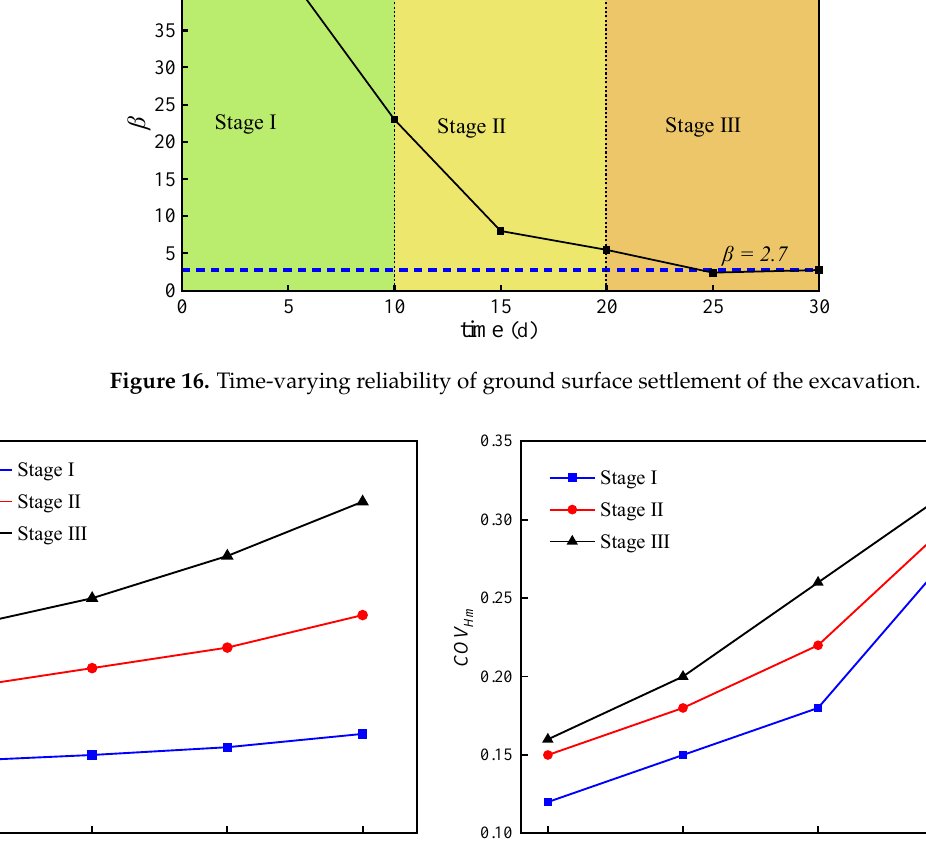
Figure 16. Time-varying reliability of ground surface settlement of the excavation.